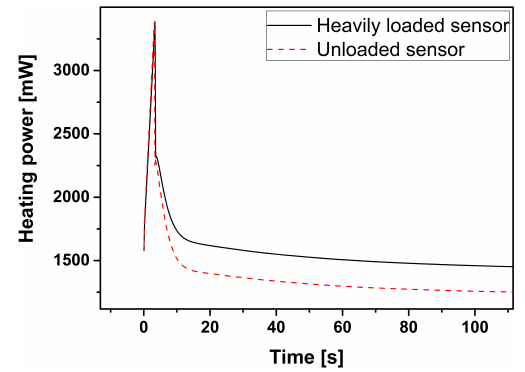
Figure 5. Dissipated heating power during thermal regeneration of a heavily loaded IDE structure (line) and a fresh IDE structure (dashed